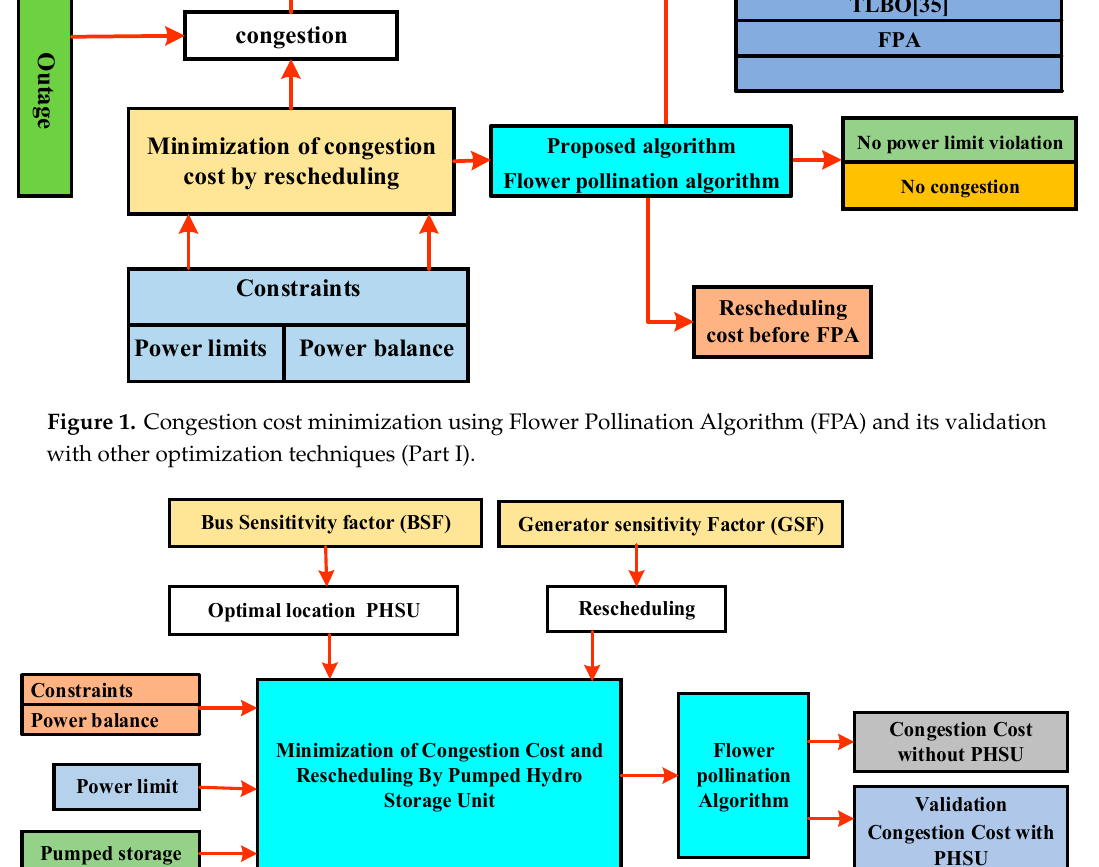
Figure 2. Congestion cost minimization using FPA incorporating Pumped Hydro Storage Unit (PHSU) and its validation (Part II).